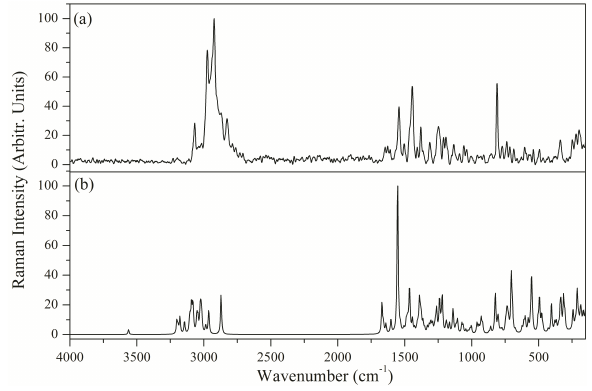
Figure 5: Experimental (a) and simulated (b) Raman spectra of the title molecule.